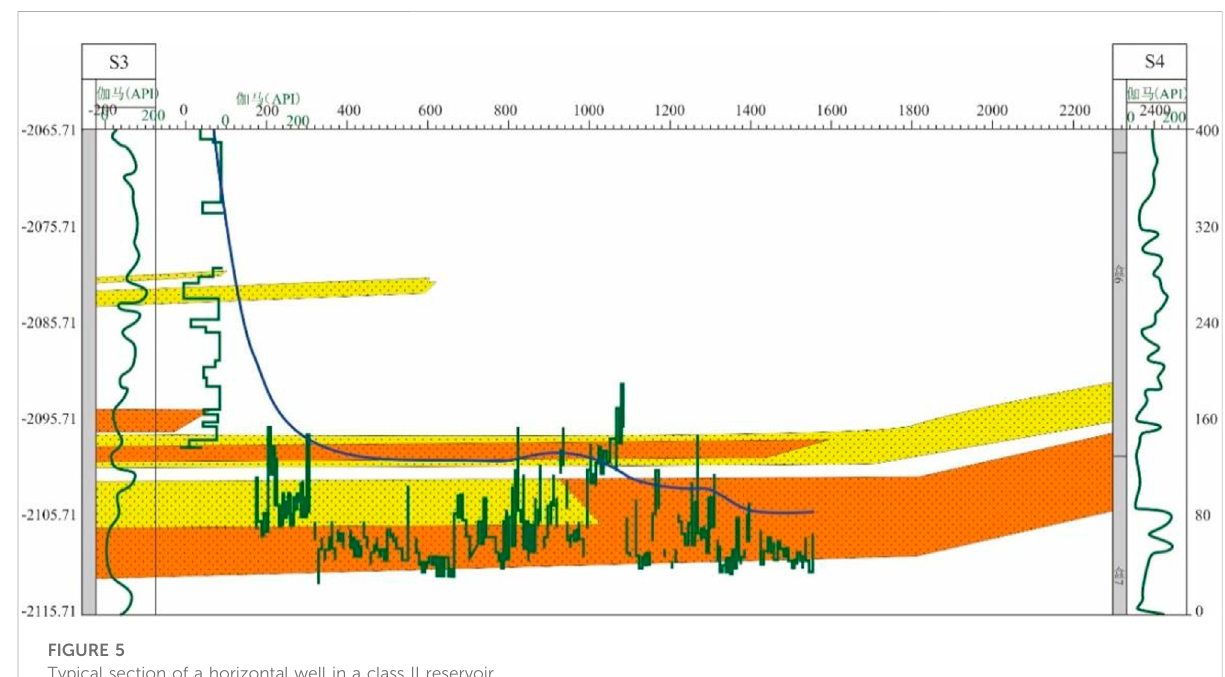
FIGURE 5 Typical section of a horizontal well in a class II